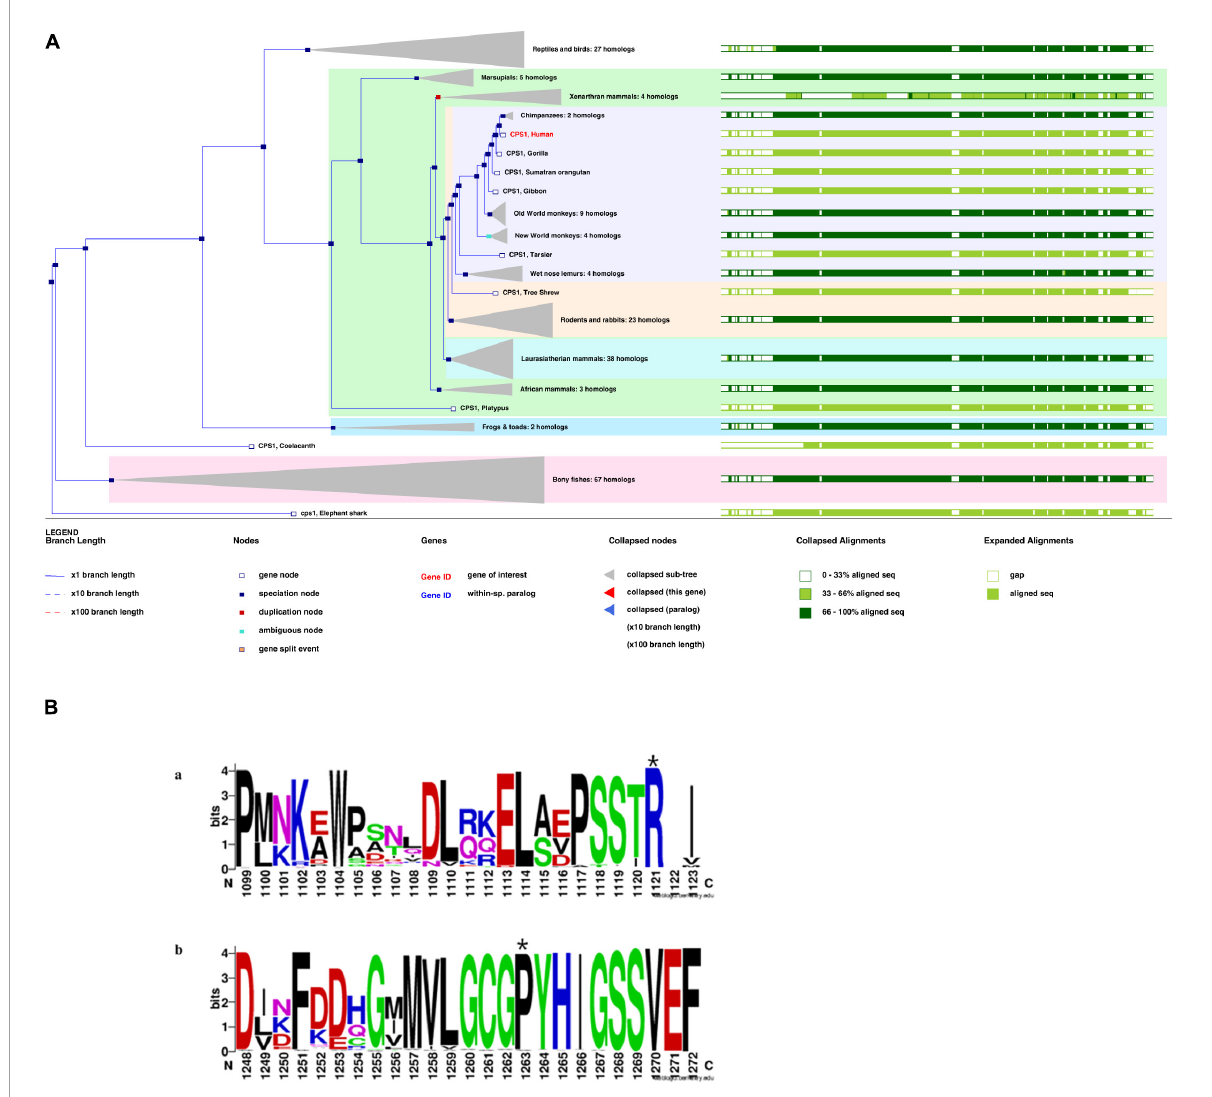
FIGURE4 (A) Phylogenetic tree of CPS1 with 197 homologous sequences from 186 species. (B) The sequence logo includes stacks of symbols for the corresponding amino acids. The height of the stack reflected the conservation of amino acids. The chemical properties of the amino acids were used to define the color system. Polar (G, S, T, Y, C, Q, and N), basic (K, R, and H), acidic (D and E), and hydrophobic (A, V, L, I, P, W, F, and M) amino acids are shown in green, blue, red, and black, respectively(Li et al., 2021). Variant sites: (A) p.R850C at the 1,121st amino acid position above the seqlogo (marked with a star). (B) p.P983S at the 1,263rd amino acid position above the seqlogo (marked with a